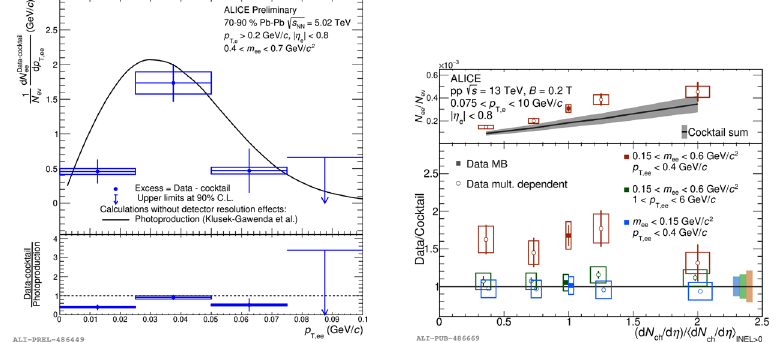
Figure 3. Left: excess dielectron yield as a function of p T , ee in 0.4 < m ee < 0.7GeV / c 2 for peripheral Pb–Pb collisions compared to calculations for γγ e + e − [3]. Right upper panel: e + e − yield in pp → collisions at √ s = 13 TeV in the excess region as a function of the event multiplicity compared with the hadronic cocktail. Right lower panel: enhancement factor data / cocktail in pp collisions at √ s = 13 TeV for three di ff erent kinematic